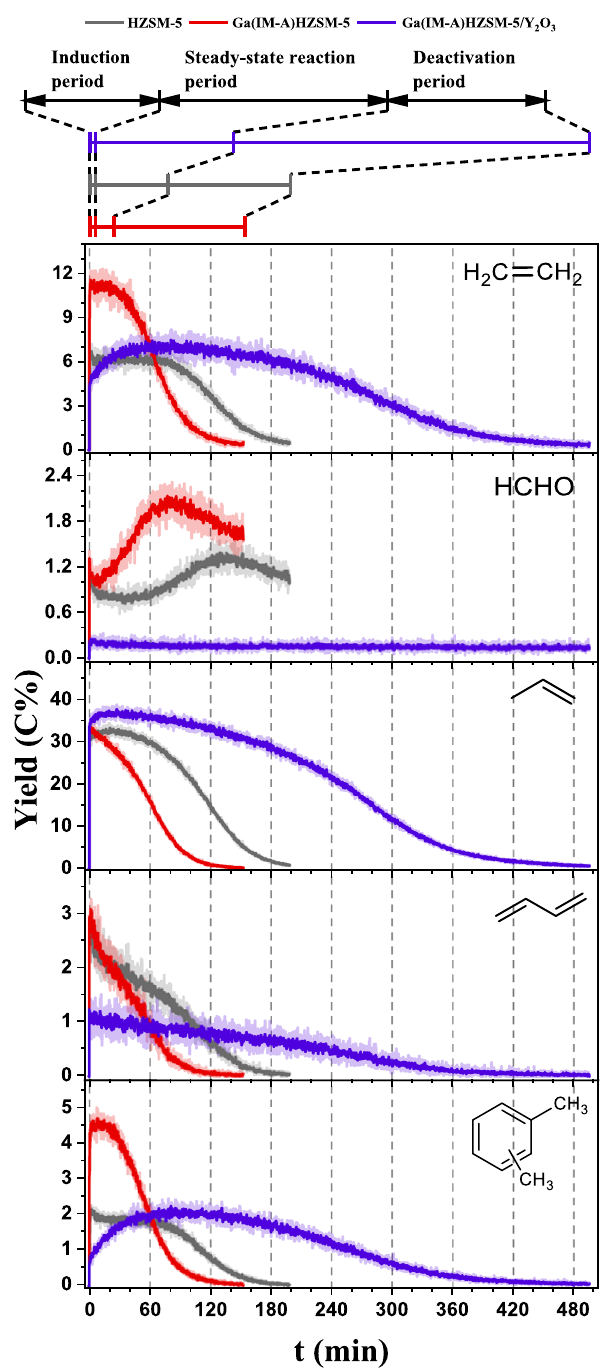
Fig. 1 Product distribution after boosting or eliminating in formaldehyde. The real-time yields (C%) of C 2 H 4 , HCHO, propylene, 1,3-butadiene and C 8 aromatics in MTH reaction over parent HZSM-5, Ga(IM-A)HZSM-5 and Ga(IM-A)HZSM-5/Y 2 O 3 . Reaction conditions: 400°C; MeOH weight hourly spacevelocity (WHSV) was 12.52 g MeOH g catalyst − 1 h − 1 ; pressure was 2Torr; and each reaction proceeded until the C 2 H 4 yield dropped to 0.5C%. The original yield curves (transparent solid lines) have been smoothed as bright solid